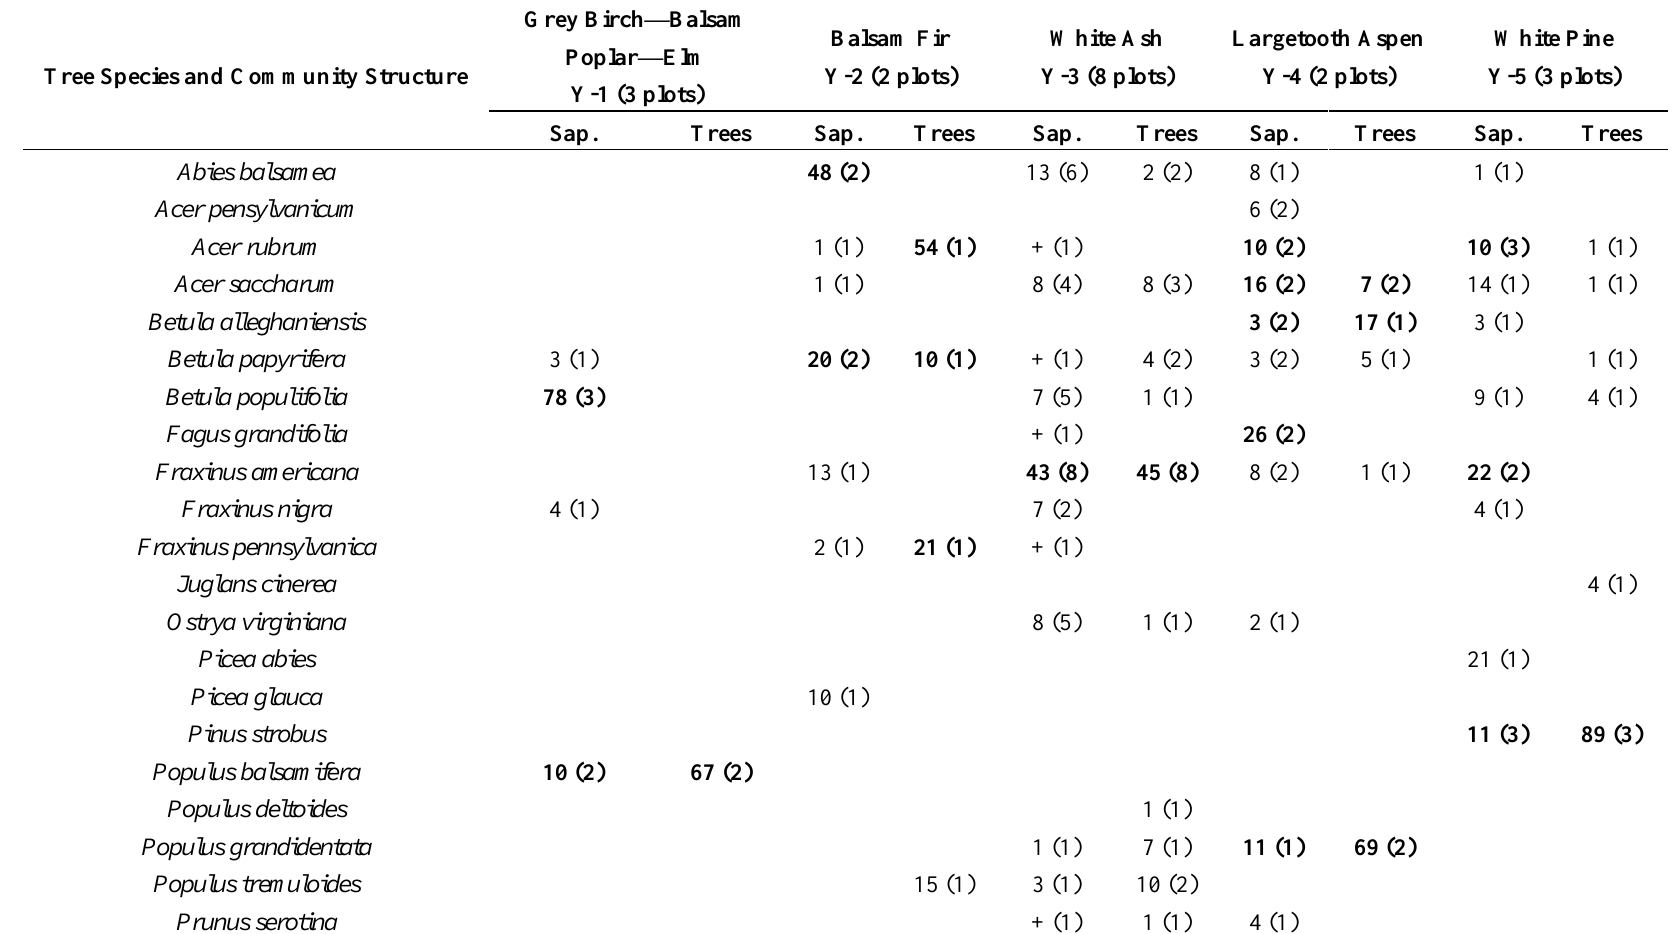
Table 1. Relative density of large saplings (5–10 cm DBH; Sap. in table) and relative basal area of large trees (>20 cm DBH; Trees in table) of the Young Forests community types of the St-Benoît-du-Lac Abbey forested areas. Means of large sapling density, tree (>10 cm DBH) density, large tree basal area, and total basal area (saplings + trees) for each community type are indicated at the bottom of the table. The number of plots in which saplings and trees of each species were recorded is given in brackets in the